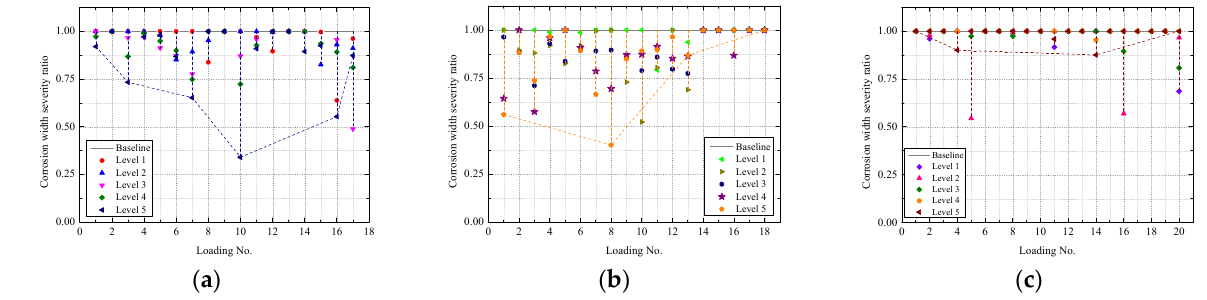
Figure 17. Changes of corrosion width severity ratio ( w c / L 0 ) under the combined loading–corrosion tests: ( a ) Sample B1, ( b ) Sample B2, and ( c ) Sample B3.